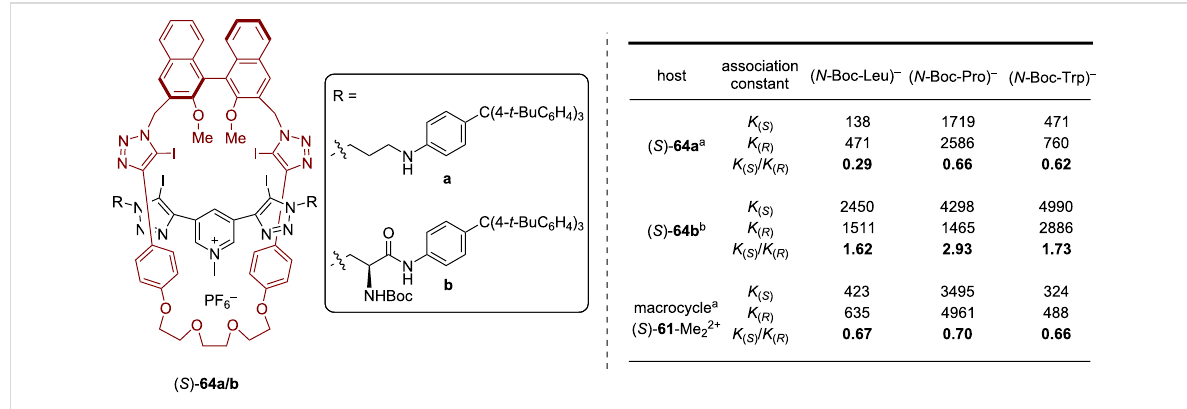
Figure 17: Association constants of different anions (used as the Bu 4 N + salts) to the [2]rotaxanes ( S )- 64a / b and the macrocycle ( S )- 61 -Me 2 2+ . Only the first association constant ( K 11 ) is given. a In acetone- d 6 /D 2 O 98:2. b In acetone- d 6 /D 2 O 99:1.